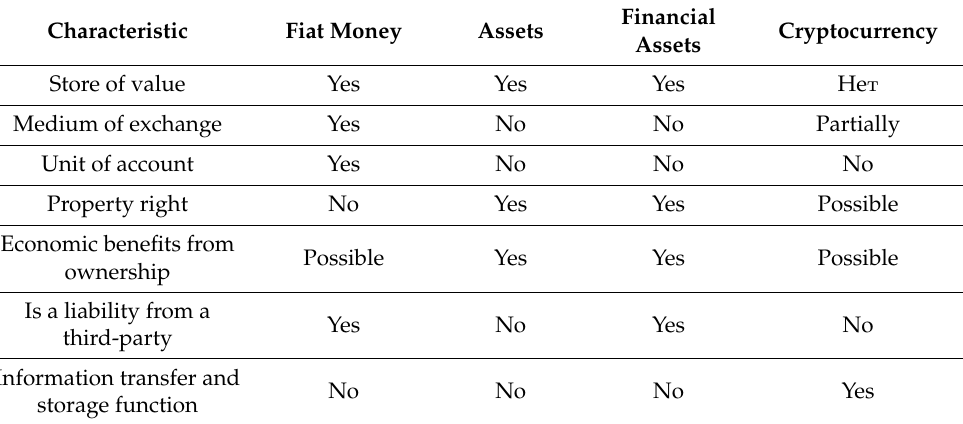
Table 1. Comparative analysis of cryptocurrencies, money and